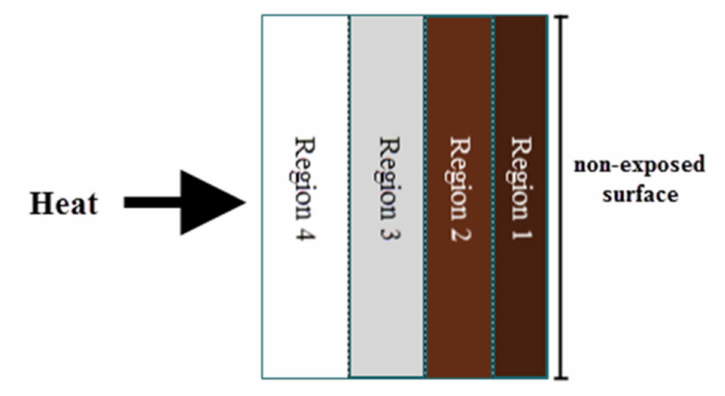
Figure 19. Diagram of color variation across geopolymer panel after fire-retardant